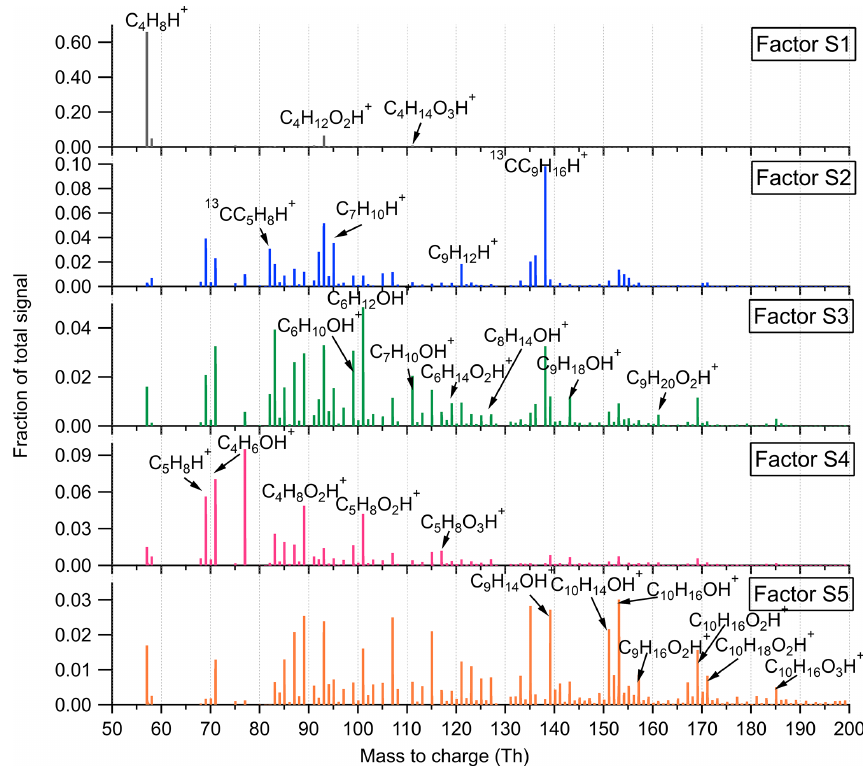
Figure 7. Mass profiles of the five factors identified in the low-mass range at the SMEAR II station, with fingerprint peaks shown in the mass